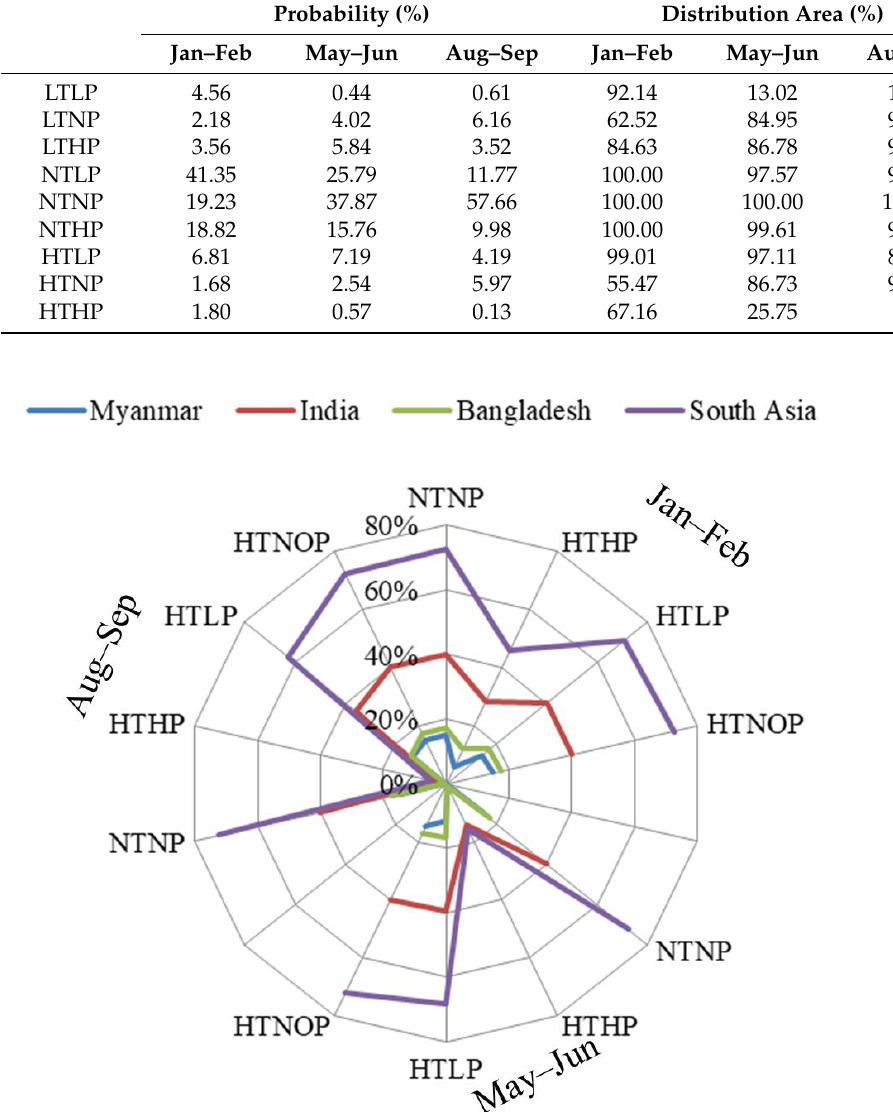
Figure 3. The cropland percentage of area that experienced extreme high temperature events during growing seasons in Bangladesh, India, Myanmar and the whole area from 2000 to 2018. (Abbreviations: NTNP–Normal temperature and normal precipitation, HTLP–Higher temperature and lower precipitation, HTNOP–Higher temperature without precipitation, HTHP–Higher temperature and higher precipitation).